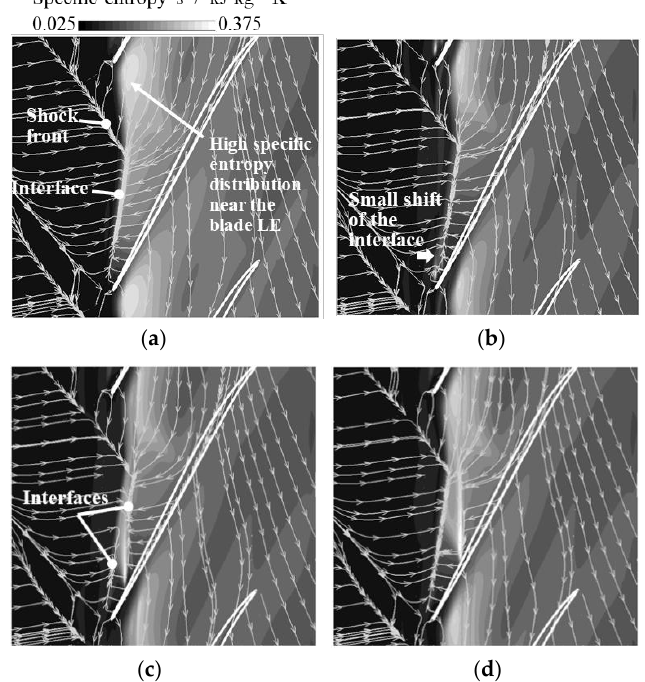
Figure 10. Surface streamlines and specific entropy color iso-levels near the casing wall showing how the confluence line (interface) around the rotor leading edge (LE) changes with a RC. View of the cascade plane close to the casing. ( a ) BL (OP-A, NS). ( b ) Case #1.-1 (OP-A). ( c ) Case #0 (OP-A). ( d ) Case #1.1 (OP-A).